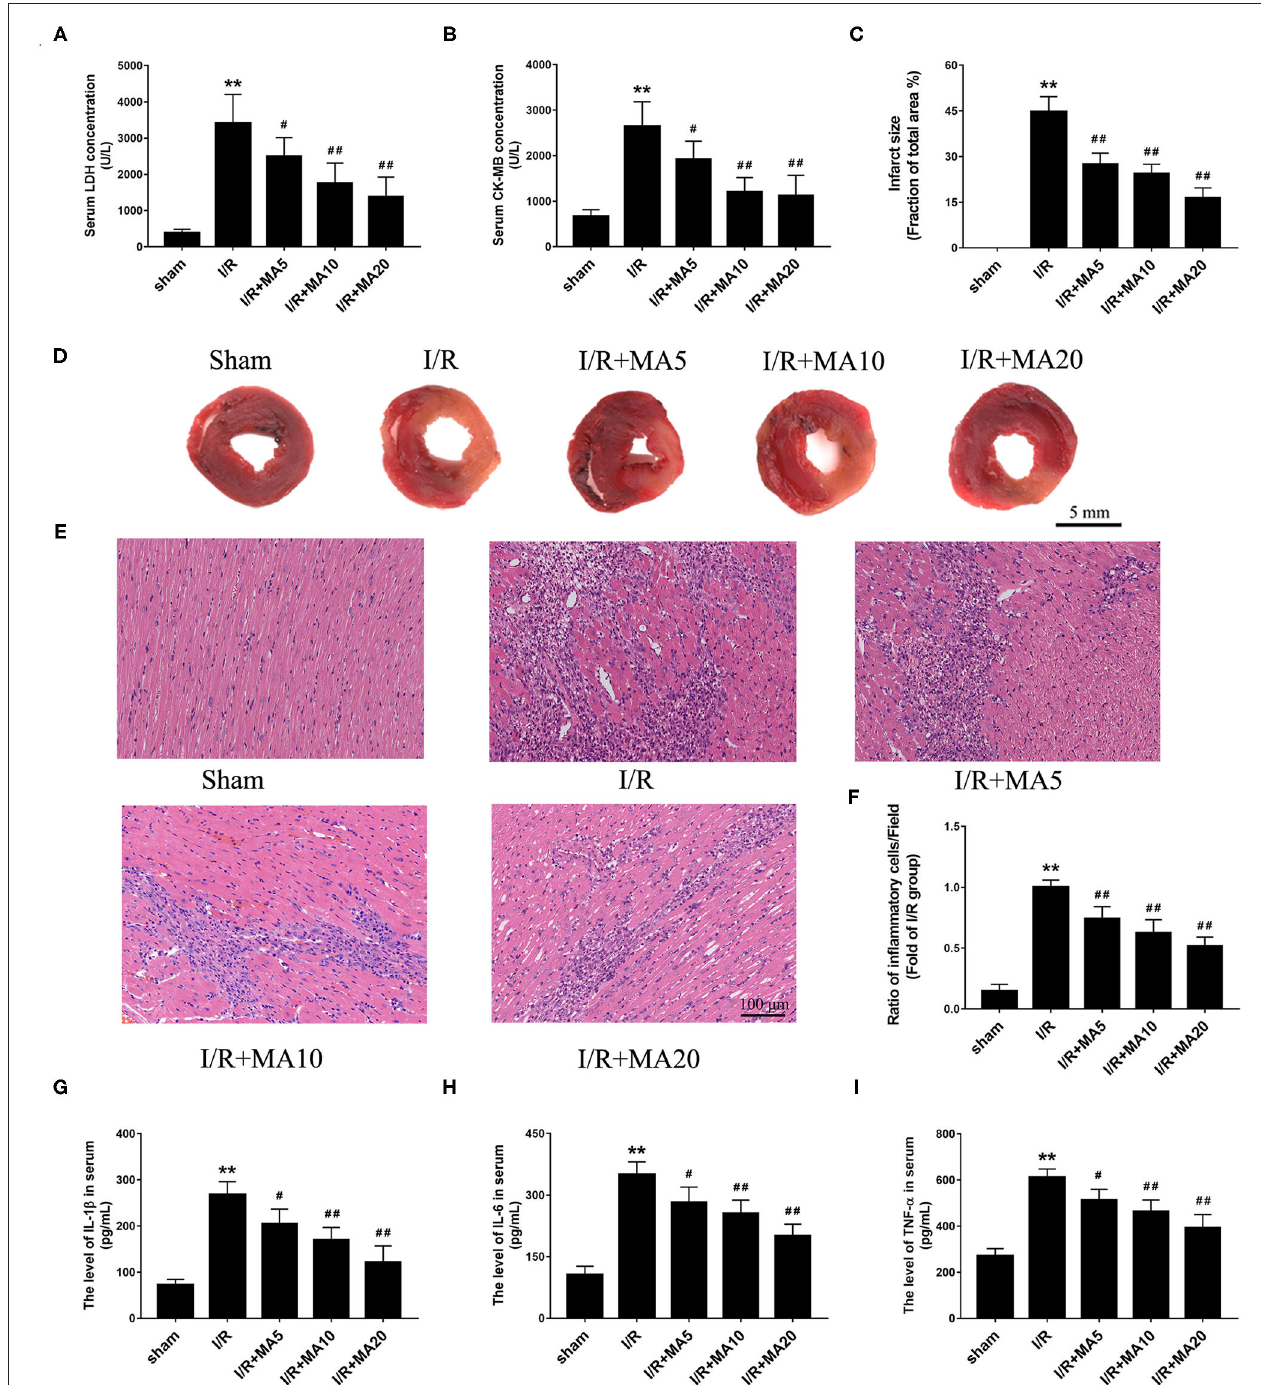
FIGURE 6 | Maslinic acid treatment ameliorated I/R-induced myocardial injury and inflammation in vivo . (A,B) After pretreating with indicated concentrations of MA (5, 10, and 20 mg/kg) and being subjected to I/R procedure, the myocardial injury was detected by LDH and CK-MB release assay ( n = 4). (C,D) Myocardial infarction was detected by 2,3,5-triphenyltetrazolium chloride (TTC) staining and the infarct size was analyzed as (white area)/(white area + red area). The representative photographs of TTC staining performed in the graph ( n = 4). (E,F) Myocardial histology and inflammatory cell infiltration are assessed by H&E staining and the results of inflammatory cell infiltration (%) within the ischemic heart are expressed in the bar graphs ( n = 4). (G–I) The levels of IL-1 β , IL-6, and TNF- α in serum was assessed by the specific ELISA analyses ( n = 3). All data are expressed as mean ± SD. ** P < 0.05 vs. control group; # P < 0.05, and ## P < 0.01 vs. H/R group.